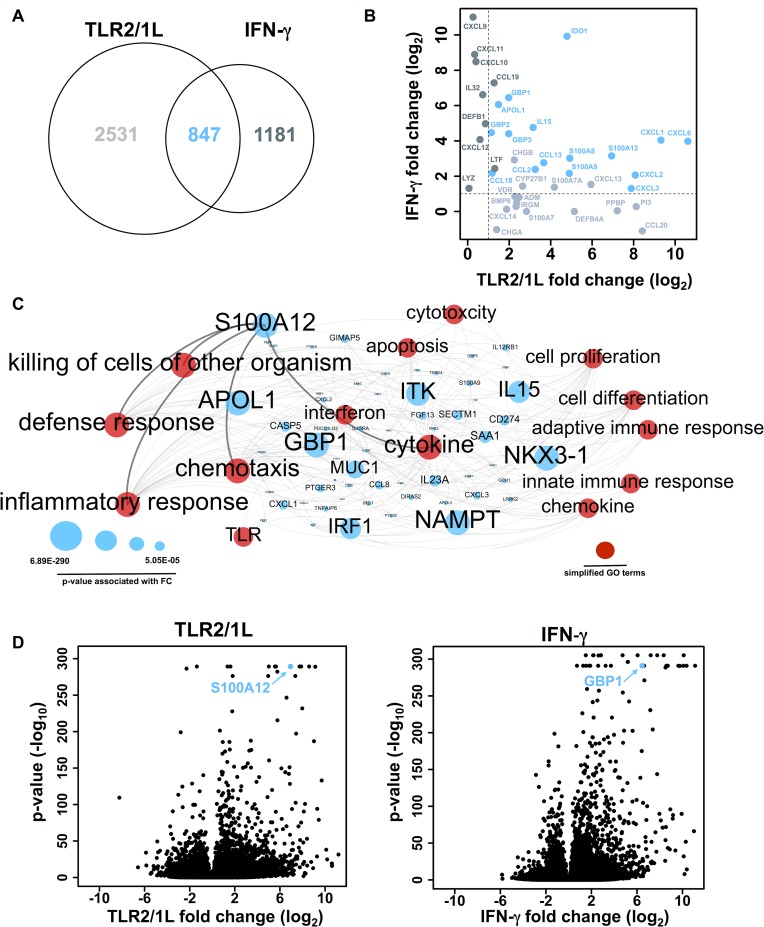
Analysis of TLR2/1L and IFN-γ inducible genes identifies common pathways.
(A) TLR2/1L and IFN-γ inducible genes defined as fold-change (FC) greater than 2 and P-value less than 0.01. Overlap indicates number of genes shared by both stimuli. (B) TLR2/1L versus IFN-γ log2(FC) of max value for antimicrobial response genes. Genes highlighted in light gray represent TLR2/1L only inducible genes, genes in dark gray represent IFN-γ only inducible genes, and genes in blue represent shared TLR2/1L and IFN-γ inducible genes. (C) Functional annotation network of robust TLR2/1L and IFN-γ inducible genes (FC>25 and P-value<0.01). Simplified GO terms are in red, genes are in blue. Size of gene node represents P-value associated with max FC; largest node has smallest P-value in dataset. (D) Distribution of max or min log2(FC) values versus associated–log10(P-value) of all genes in dataset. Genes of interest are indicated in blue.